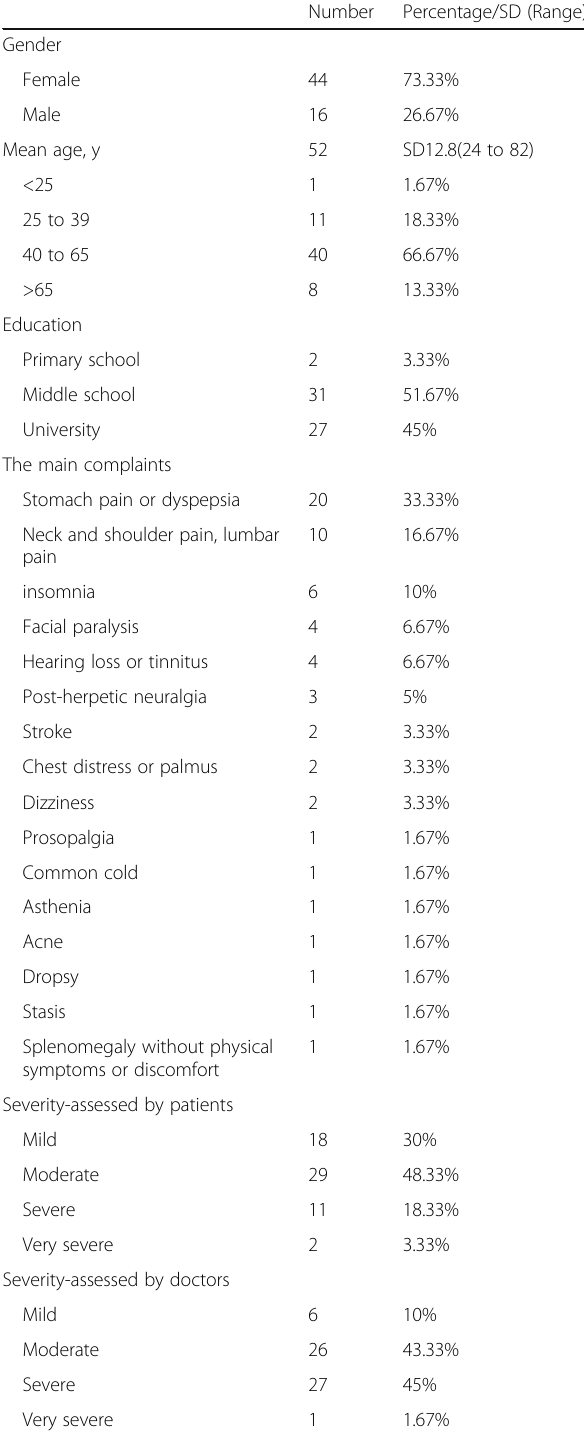
Table 1 Sample Characteristics: Patient Demographics ( N =